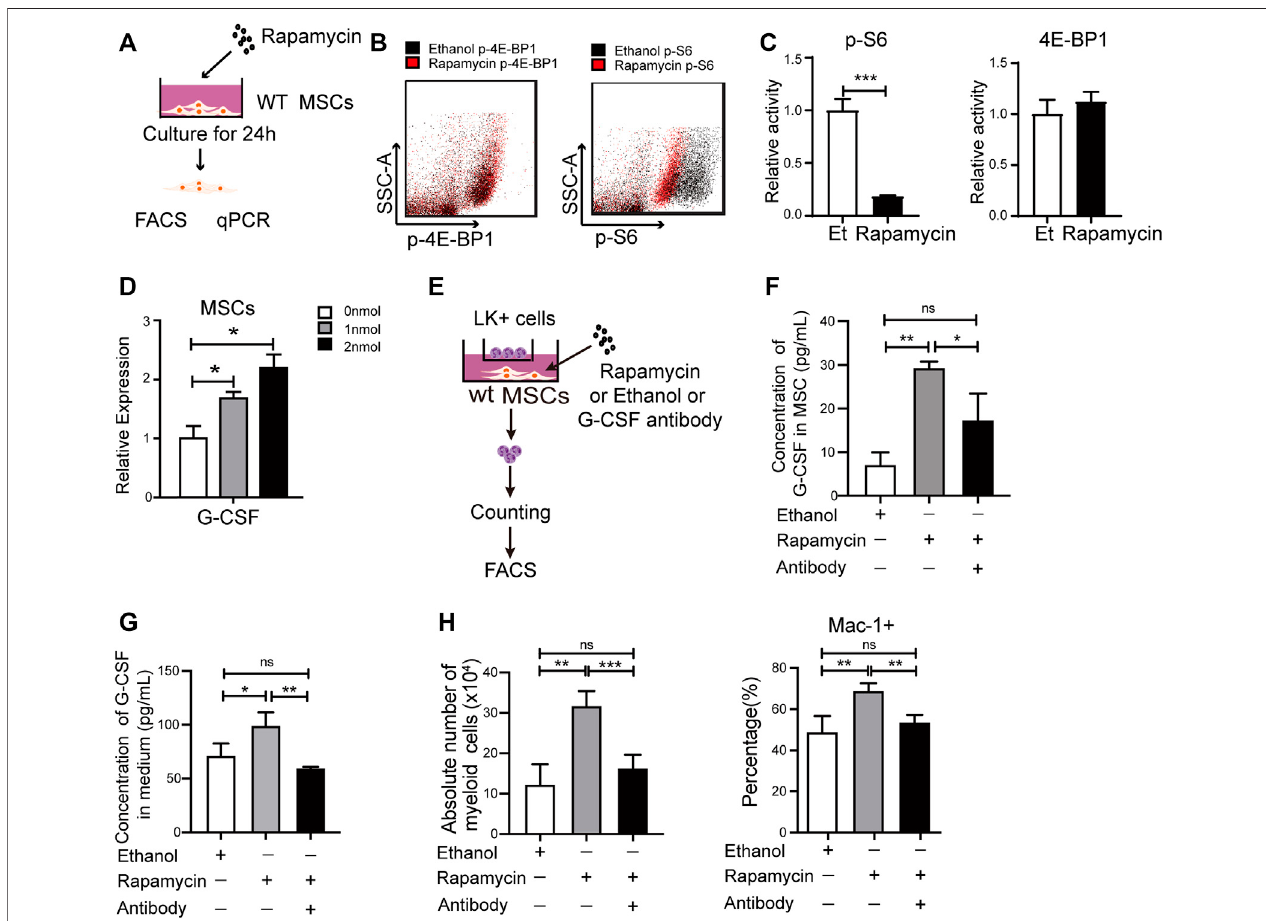
FIGURE5| RapamycinincreasedG-CSFexpressioninMSCs invitro (A) ExperimentdesignforMSCstreatedbyrapamycin invitro (B – C) Fluorescenceintensityof p-S6 and p-4E-BP1 in MSCs treated by rapamycin or ethanol in vitro (D) mRNA expression of G-CSF in MSCs treated by rapamycin or ethanol in vitro (E) Experiment designfortheco-cultureofMSCandLK + cells (F) TheproteinlevelsofG-CSFinthecelllysatesofMSCtreatedbyrapamycinorethanol (G) TheG-CSFlevelinthemedia of MSC treated by rapamycin or ethanol (H) The percentage (Left panel) and absolute number (right panel) of myeloid cells after coculturing with MSCs treated by rapamycin + G-CSF antibody, singel rapamycin, or ethanol.